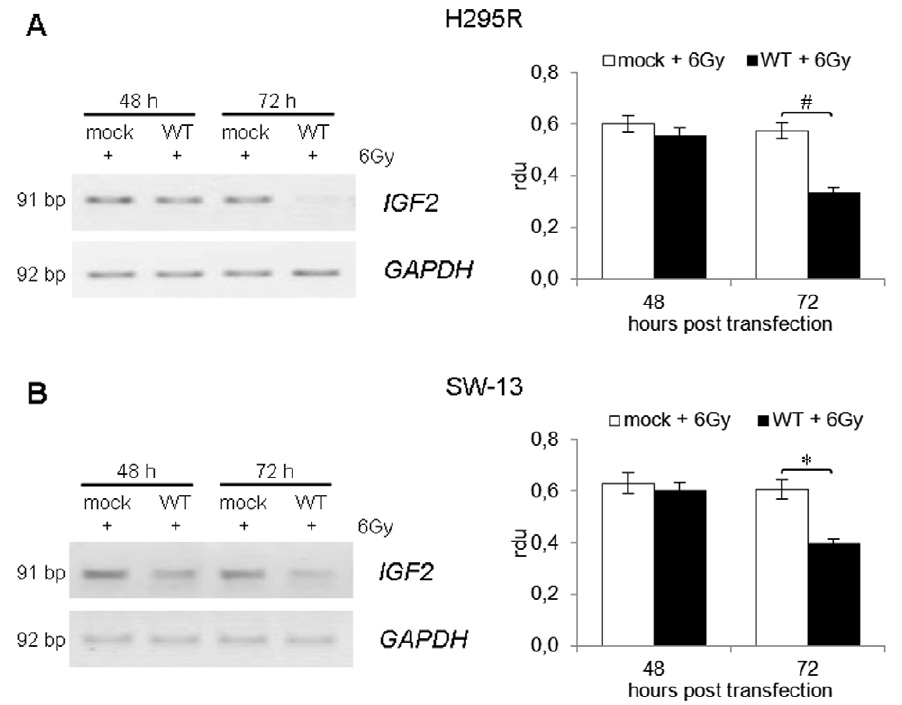
Figure 5. RT-PCR analysis of wt p53 effect on IGF2 expression. (A) Inverted images relative to semi-quantitative RT-PCR analysis of IGF2 gene expression performed on H295R cells, showing a massive loss of IGF2 signal in irradiated cells at 72 h after transfection of p53-vector (WT). (B) RT-PCR analysis of IGF2 mRNA levels performed on SW-13 cells. A significant reduction in IGF2 expression is detectable in cells transfected with p53-vector (WT) following ionizing radiations treatment. Images are representative of three independent experiments. GAPDH expression was used for normalization and bands’ intensities were quantified using ImageJ. Band densitometry is shown in the right panels. (*, p , 0.05; # , p , 0.01).